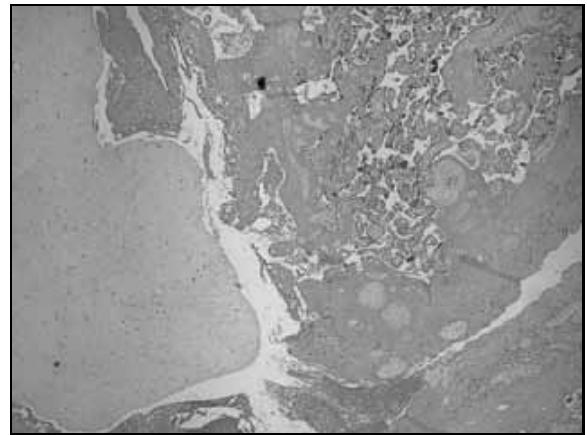
Figura 1 – Imagem ultrassonográfica